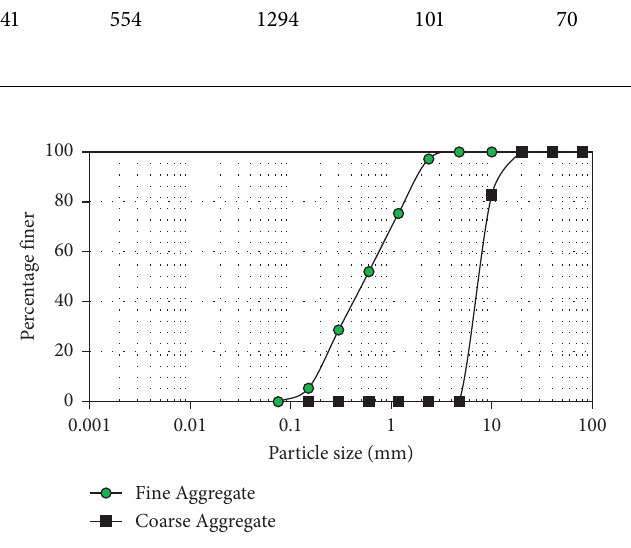
Figure 2: Aggregate particle size